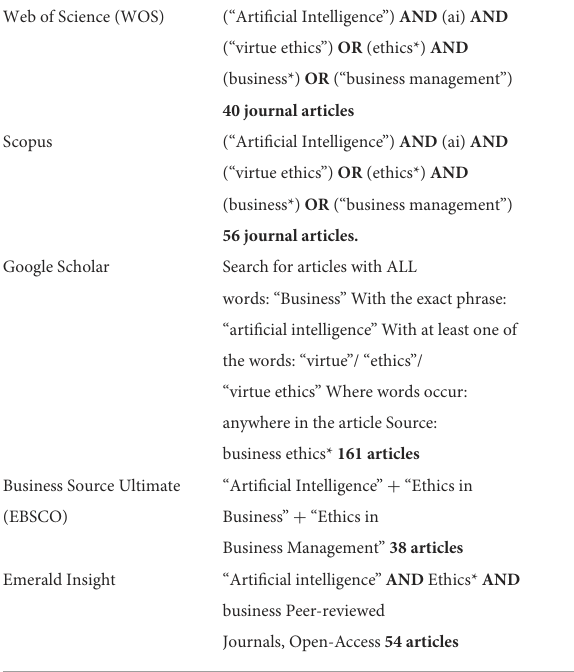
TABLE 2 Search strategy. The search strategy of documents from